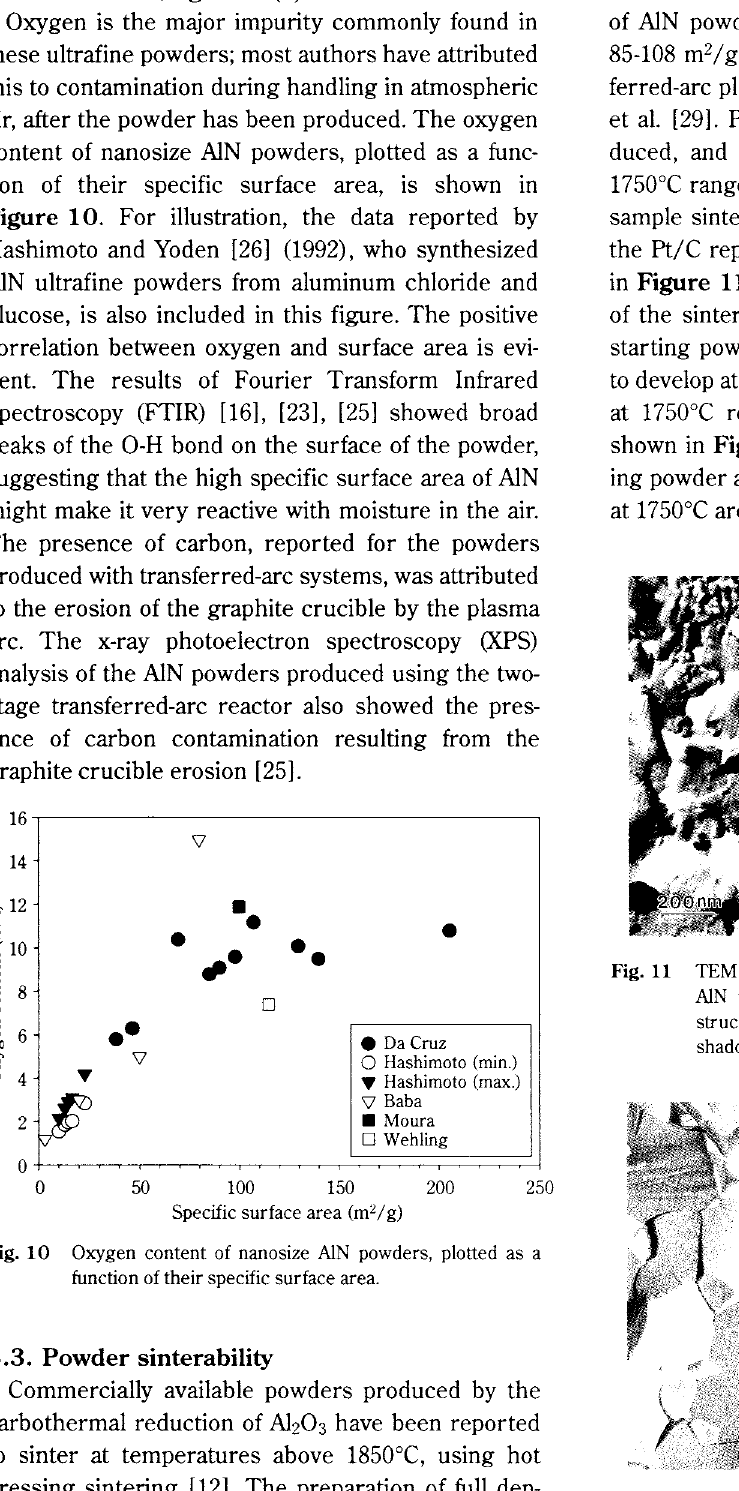
Fig. 10 Oxygen content of nanosize AIN powders, plotted as a function of their specific surface area.